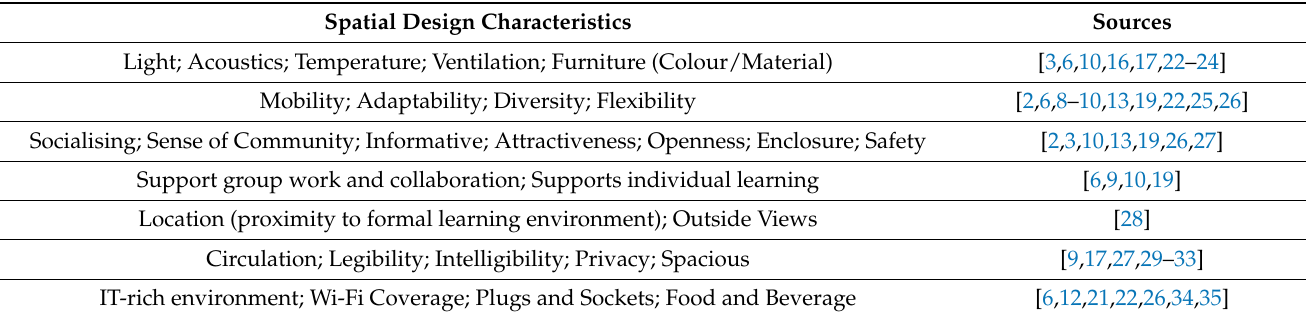
Table 1. Spatial design characteristics of learning spaces that impact students’ experiences, as drawn from literature. Spatial Design Characteristics